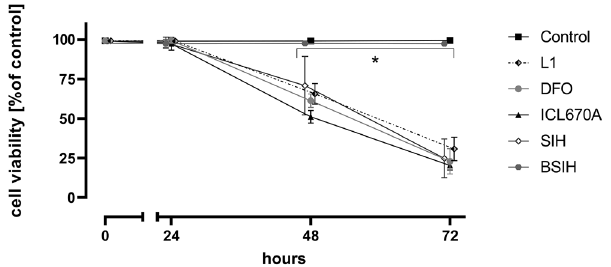
Figure 8. Comparison of own cytotoxic effect of Fe chelators DFO, ICL670A, L1, SIH and prochelator BSIH (all 100 µM) in differentiated PC12 cells. Cellular toxicities were determined after 24 h, 48 h and 72 h incubation using SYTOX measurement, expressed as a percentage of viable cells and were related to untreated control (DMSO). Data are presented as means ± SD ; n ≥ 4; Statistical significance (ANOVA, p ≤ 0.05): * vs. Control group.